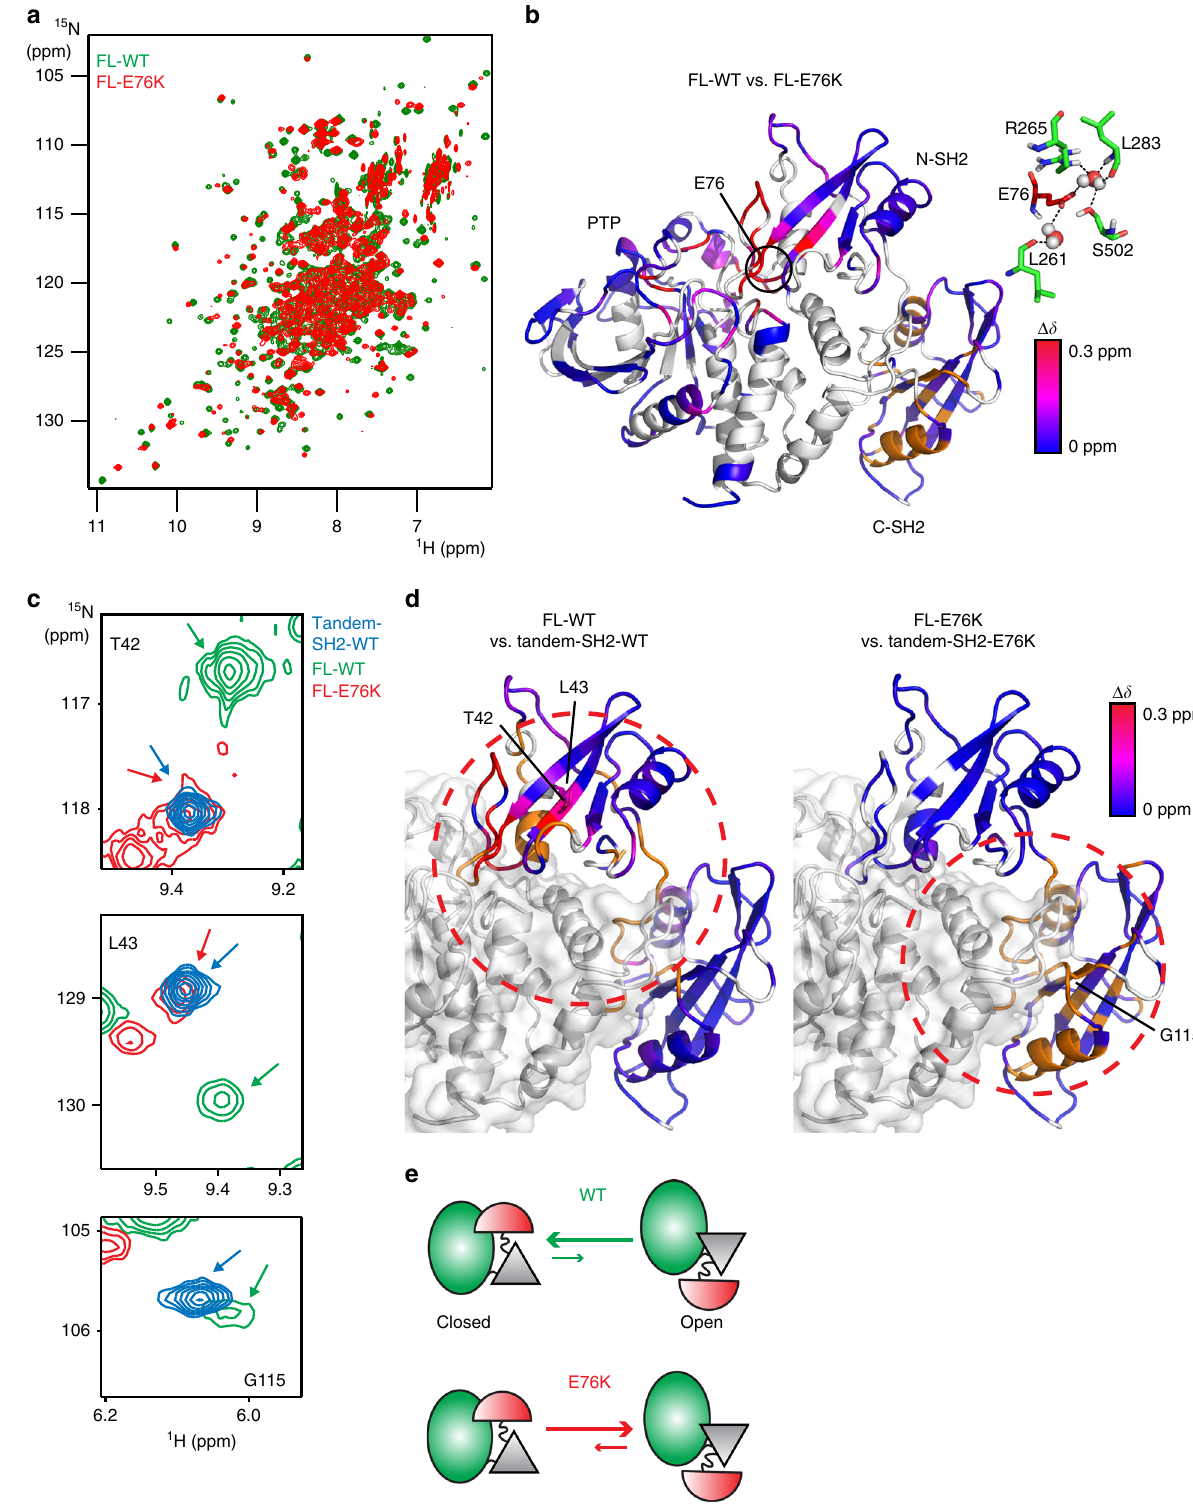
SH2 construct (Fig. 1d). The lack of chemical shift perturbations indicates that in solution the N-SH2 lacks contacts with the PTP in SHP2. To verify this “ free ” N-SH2 hypothesis, SAXS experiments were performed on the FL-E76K and FL-WT proteins. In con fi rmation of our NMR data, the calculated structure in